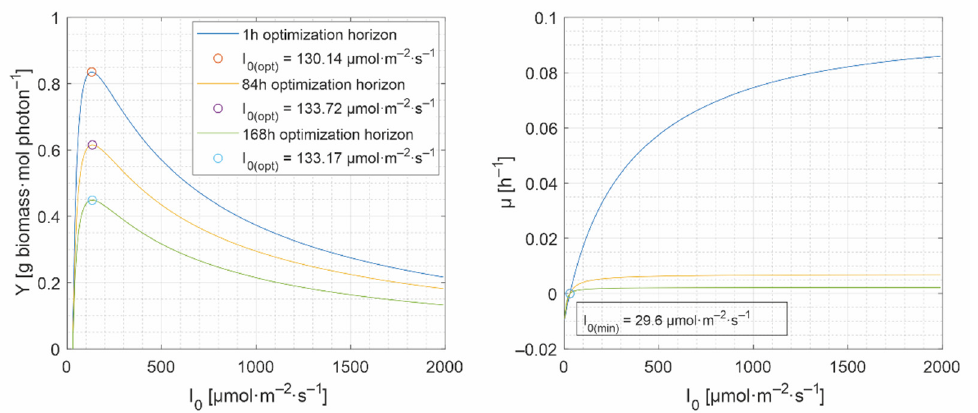
Figure 5. The responses of the system for I 0 ∈ [ 1, 2000 ] µ mol · m − 2 · s − 1 , with three different optimiza- tion horizons.